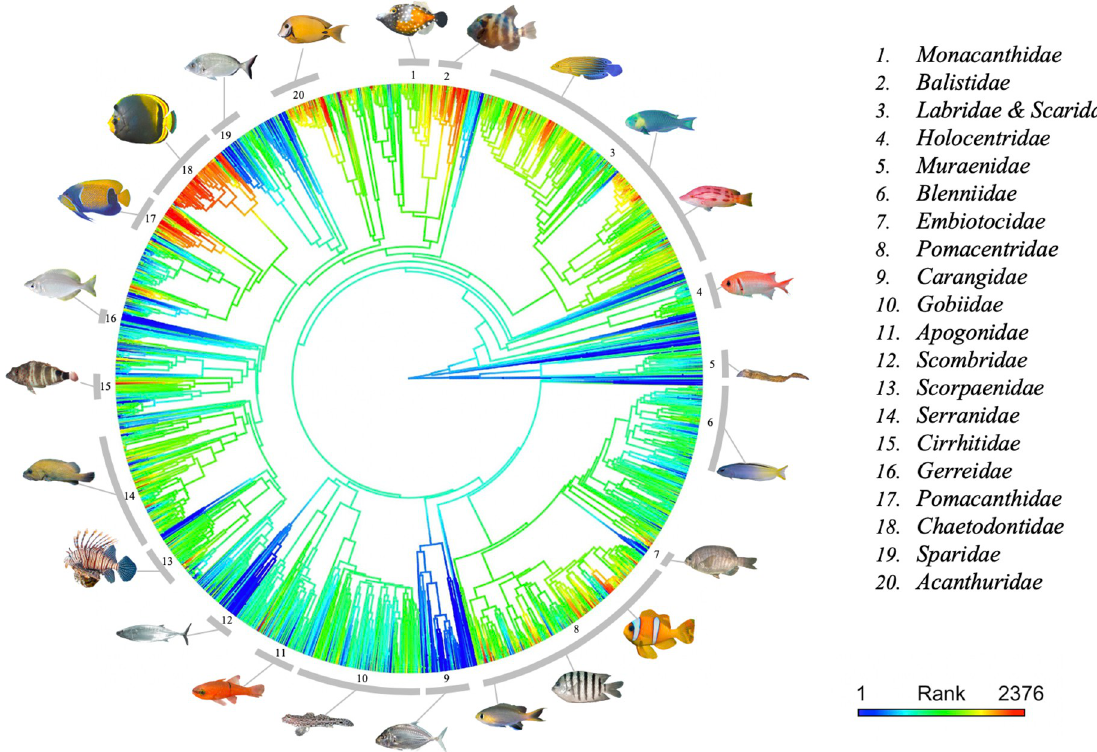
Fig 4. Aesthetic values across the tree of life. Phylogenetic tree of the 2,417 fishes. Aesthetic values are mapped over the entire phylogeny with a color gradient obtained by estimating states at internal nodes with maximum likelihood [36]. For illustration, we have highlighted 20 families with contrasted aesthetic values using gray arcs and show examples of fishes for each family. Clockwise order: Cantherhines macrocerus , Pseudobalistes naufragium , Anampses femininus , Scarus spinus , Bodianus unimaculatus , Myripristis jacobus , Gymnothorax annasona , Meiacanthus atrodorsalis , Embiotoca jacksoni , Amphiprion bicinctus , Abudefduf bengalensis , Chromis alpha , Carangoides chrysophrys , Istigobius decoratus , Apogon pacificus , Sarda australis , Pterois miles , Acanthistius ocellatus , Amblycirrhitus pinos , Parequula melbournensis , Pomacanthus navarchus , Chaetodon flavirostris , Diplodus puntazzo , Acanthurus tristis . See S1 Data for image copyright. Data and code required to generate the phylogenetic tree can be found in https://github.com/nmouquet/RLS_AESTHE.